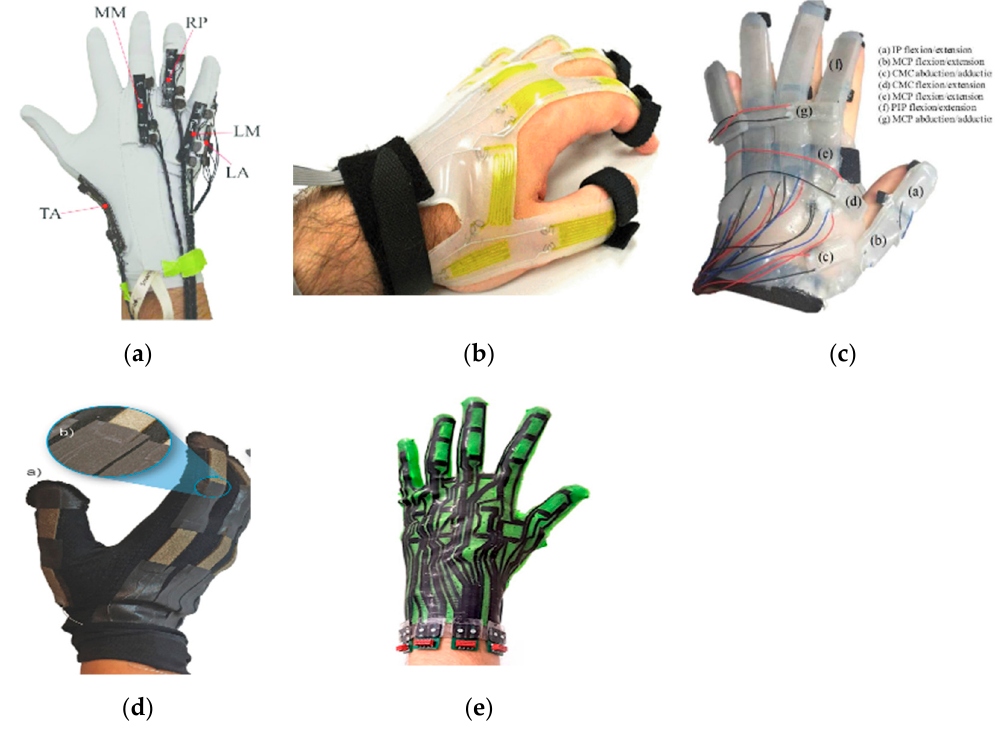
Figure 4. Data glove made with stretch (strain) sensors. ( a ) A kinesthetic glove composed of five piezoresistive fabric (KPF) goniometers [33]; ( b ) wearable soft artificial sensing skin made of a hyperelastic elastomer material [36]; ( c ) data glove made of soft Ecoflex material [37]; ( d ) wearable glove based on highly stretchable textile–silicone capacitive sensors [38]; ( e ) glove made of a full soft composite of a stretchable capacitive silicone sensor array [41]. TA: Thumb Abduction; MM: Middle Metacarpal; RP: Ring Proximal; LM: Little Metacarpal; LA: Little Abduction.